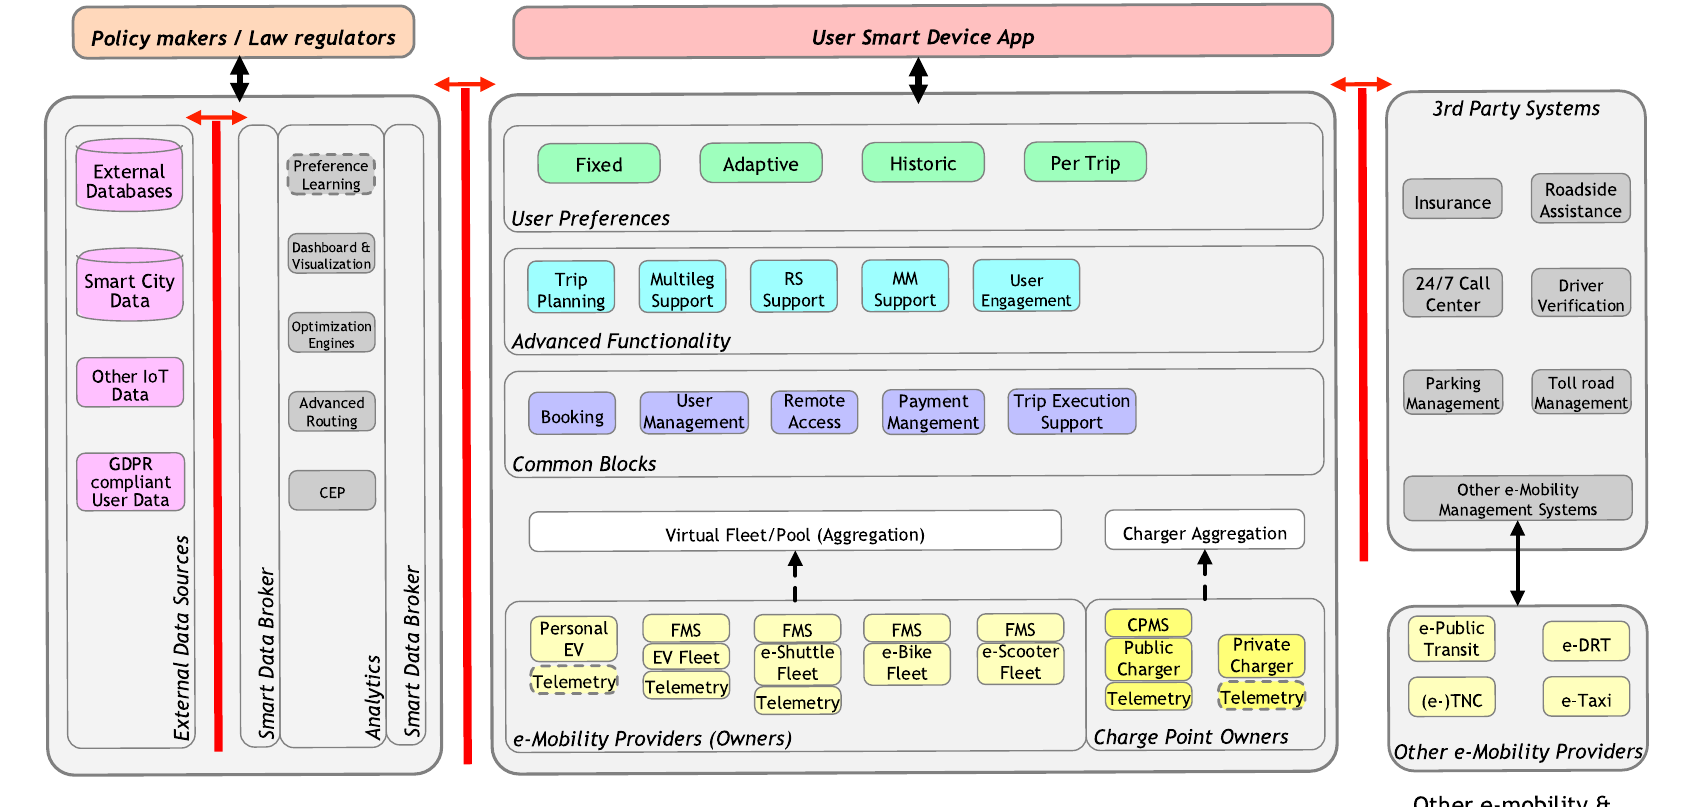
Figure 8. The eMaaS system